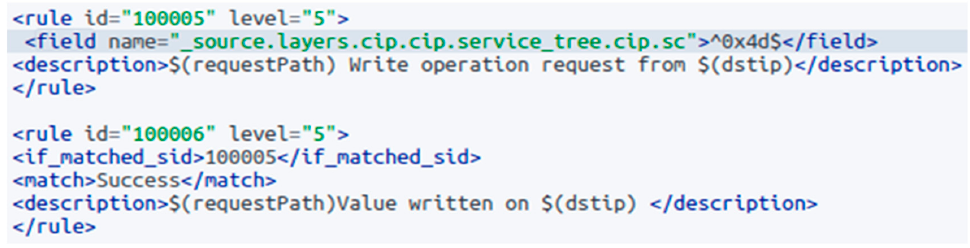
Figure 13. Rules to Monitor SWaT Network Communications.